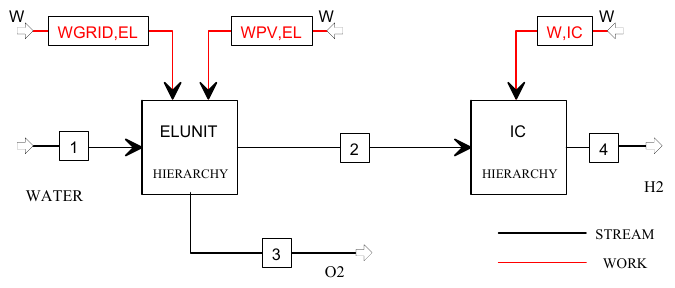
Figure 6. Flowsheet of the H2O_PV plant model.